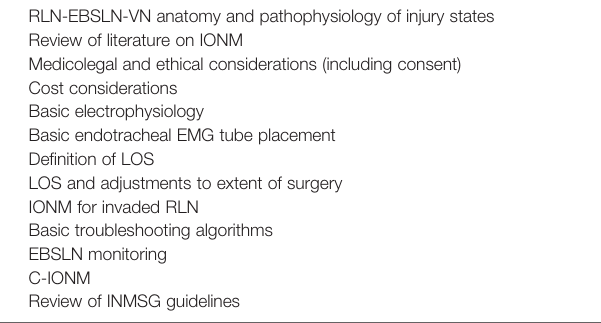
TABLE 2 | INMSG Recommendation for IONM training course content.